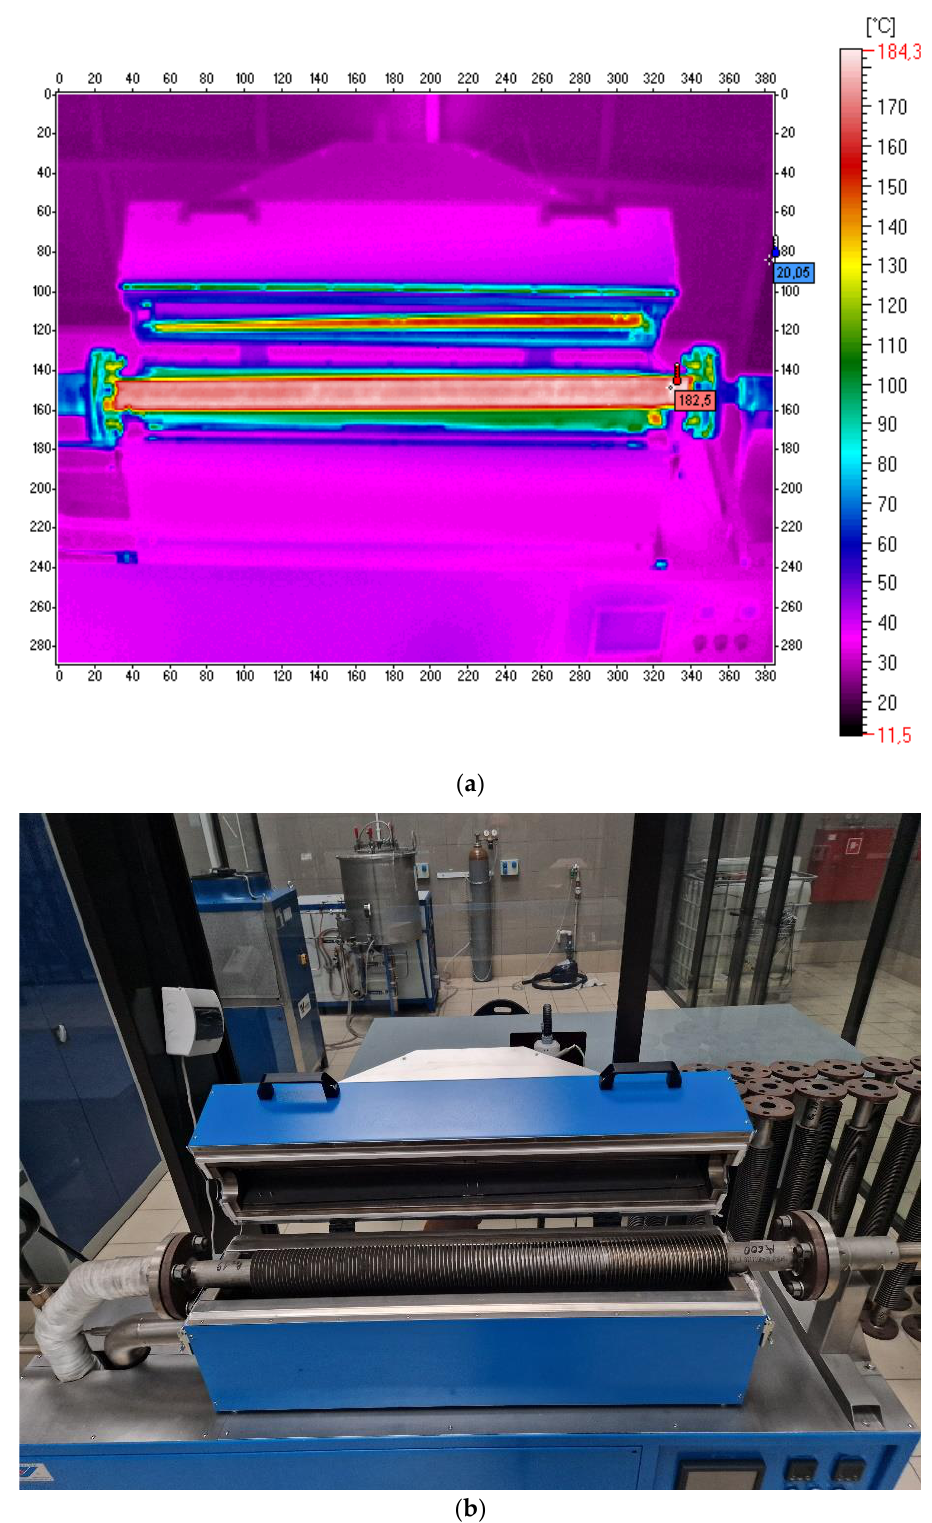
Figure 4. Temperature distribution in a finned tube during the experiment: ( a ) even temperature distribution in the finned pipe and thermographic camera, and ( b ) the actual test stand built at Energoinstal SA,